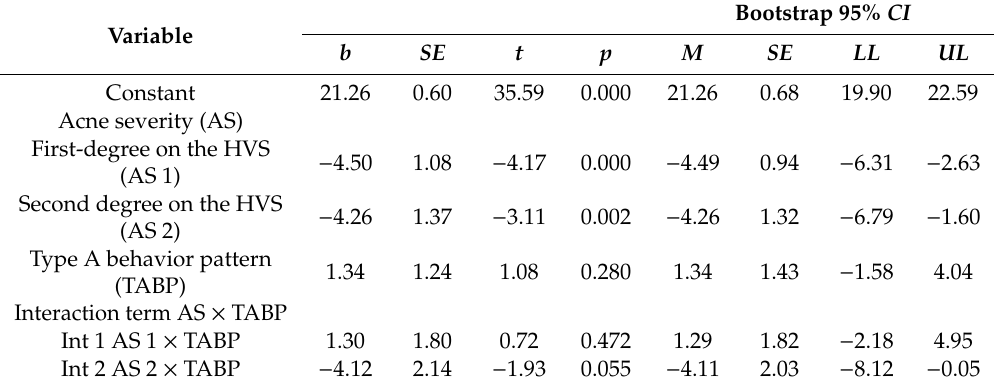
Table 5. Results of the moderation analysis for satisfaction with life as a dependent variable, acne severity as an independent variable, and dichotomous TABP as a